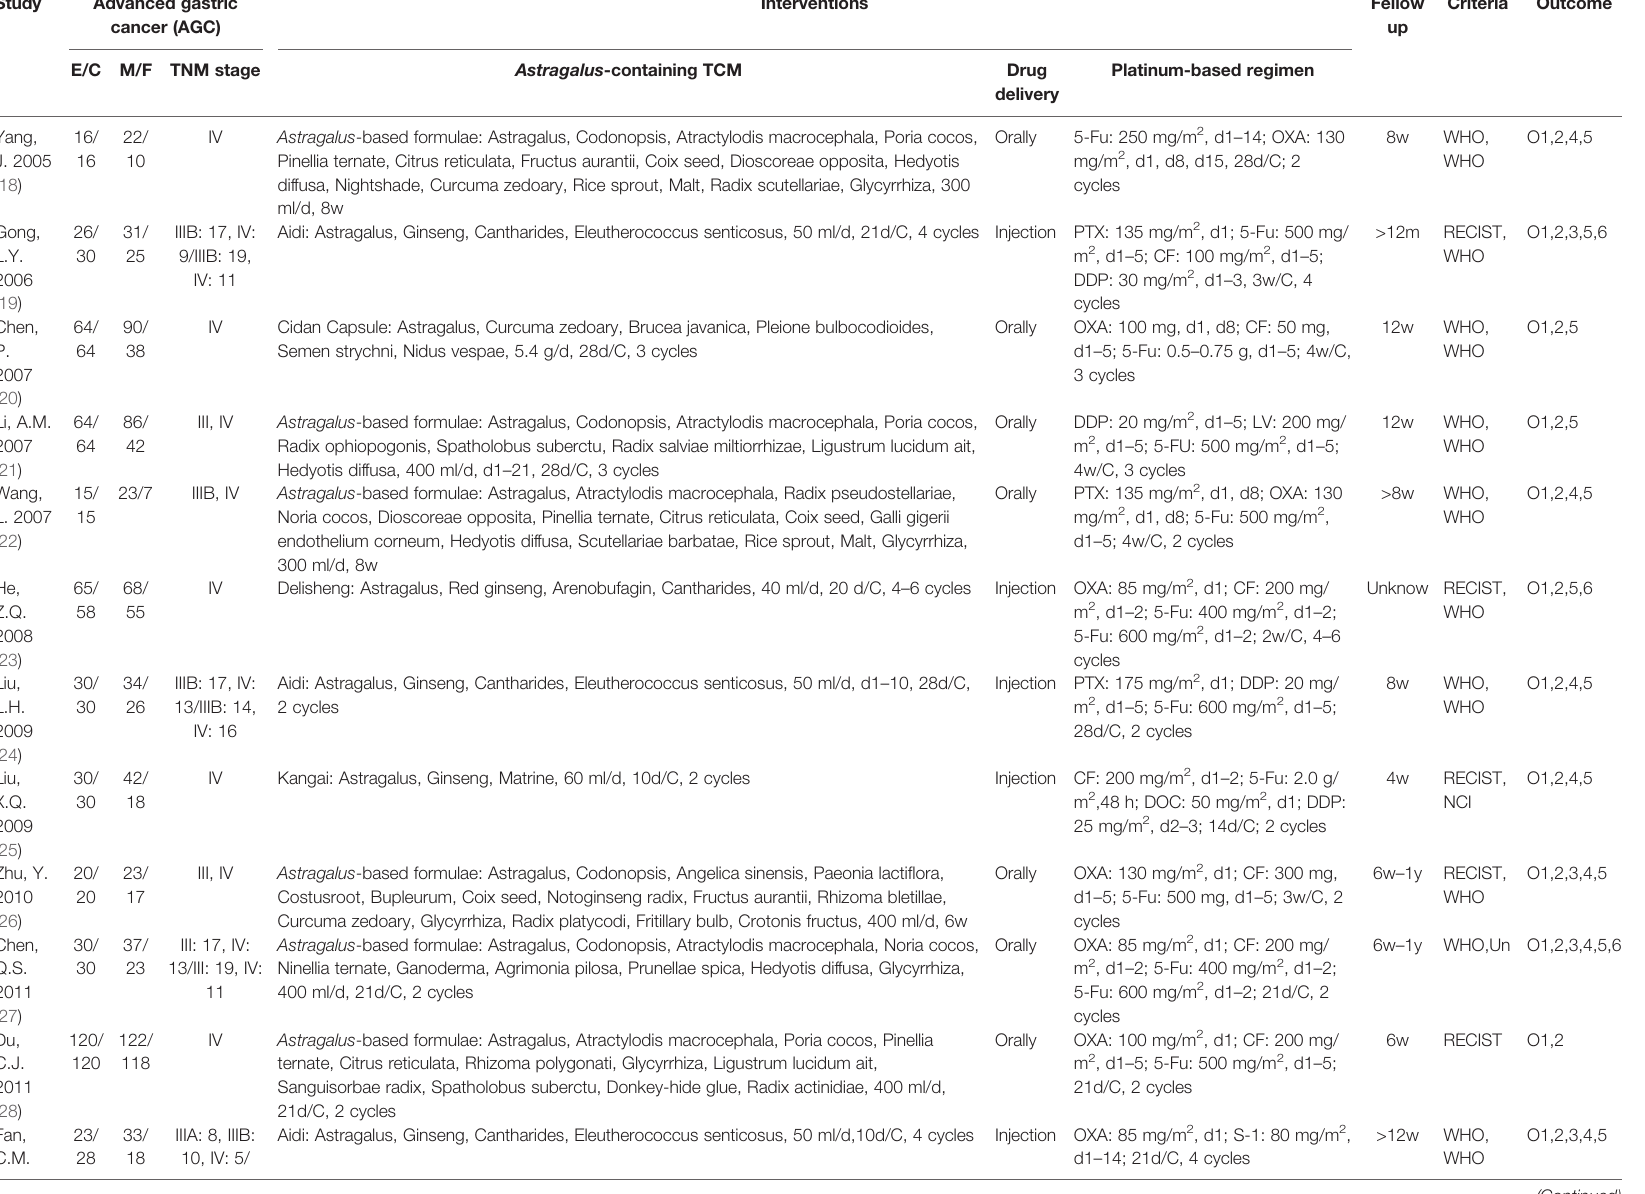
TABLE 1 | Characteristics of the included studies.